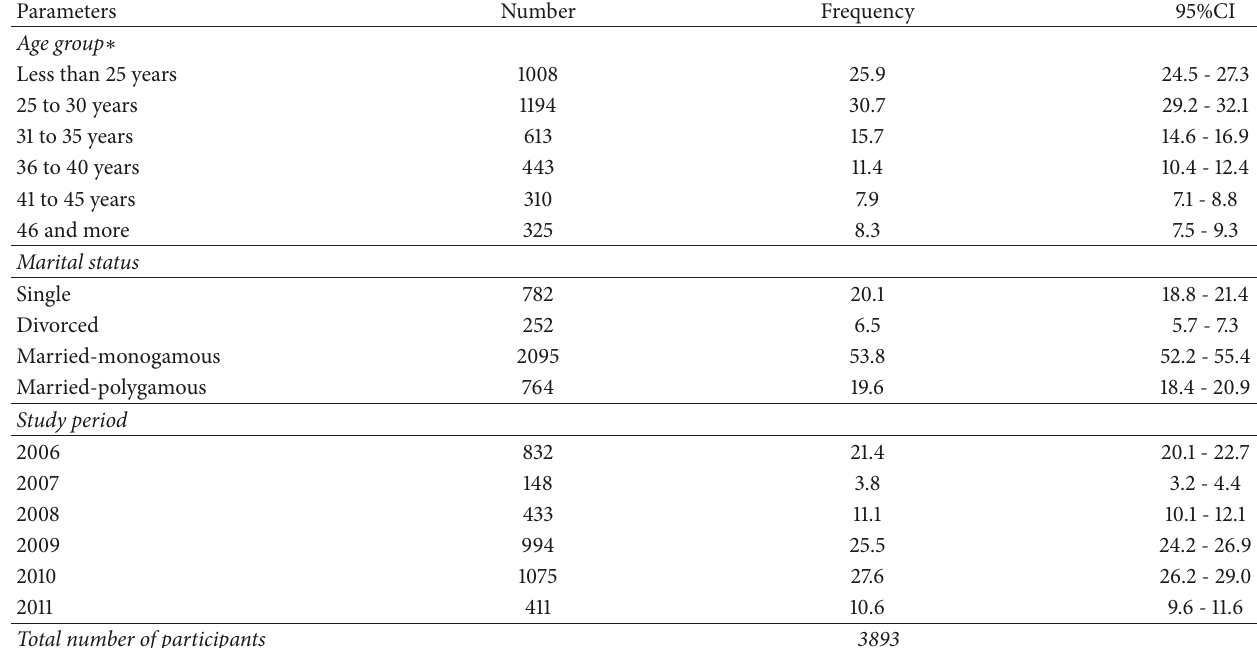
Table 1: Study participants’ characteristics.